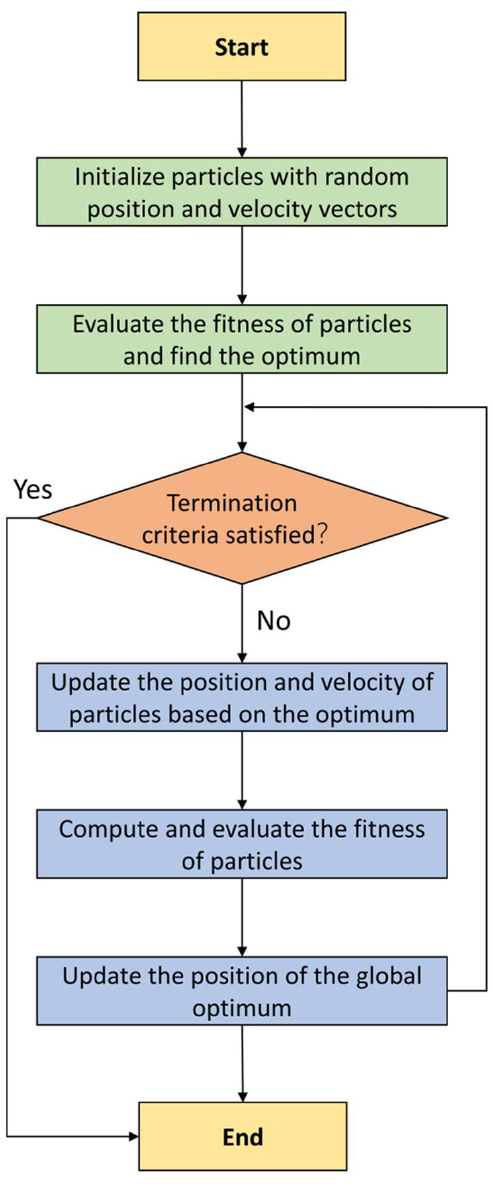
Figure 2. PSO algorithm to optimize problems.